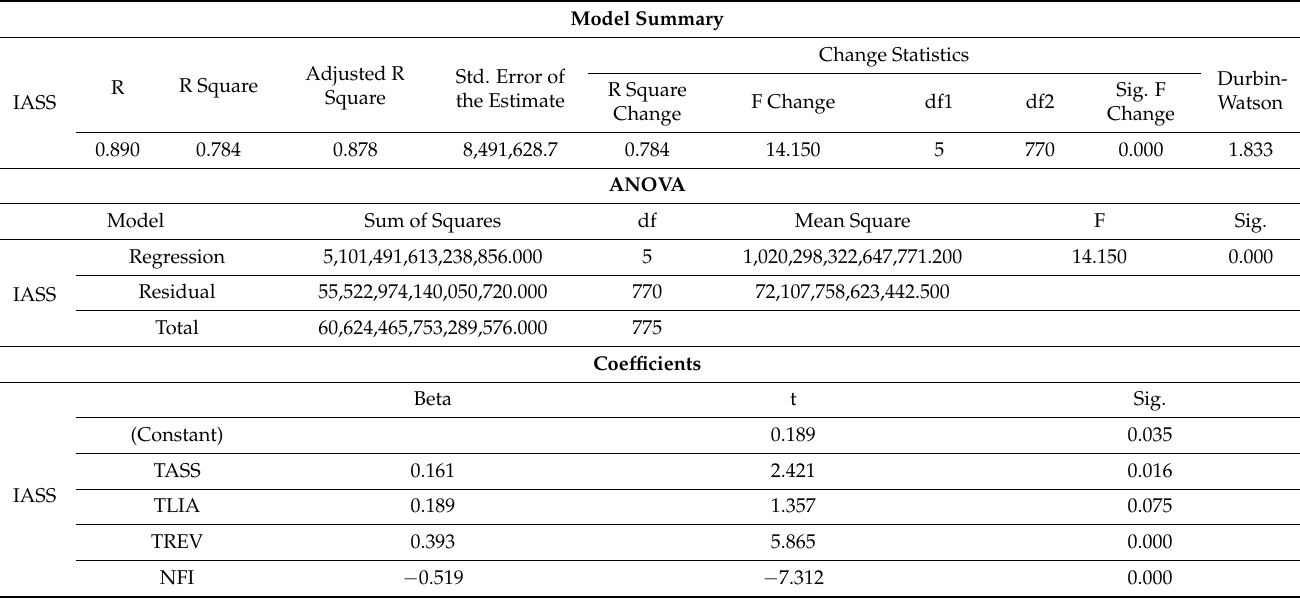
Table 9. Multiple regression analysis for factor